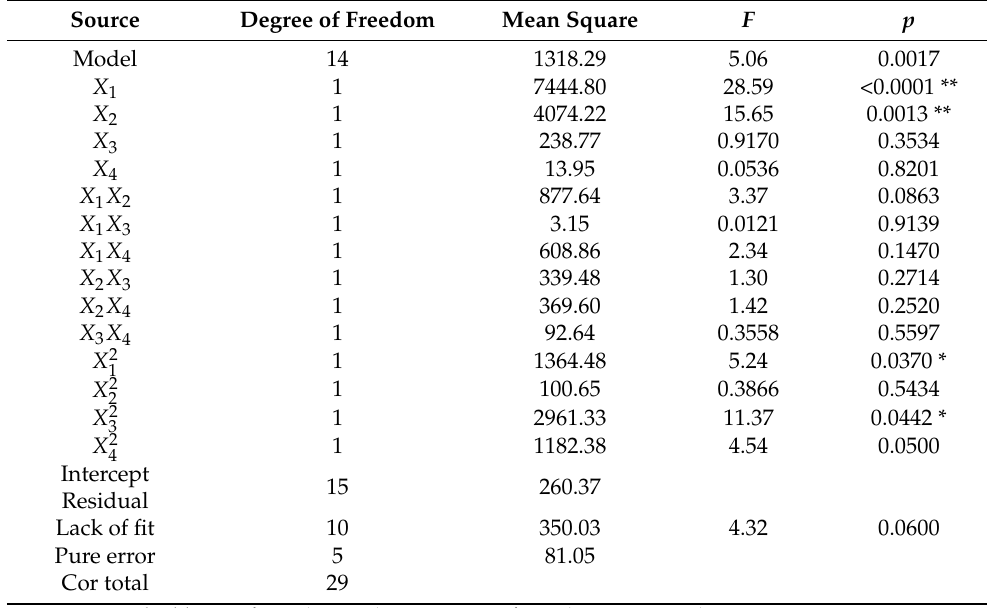
Table 5. Bending damage force response surface quadratic regression model analysis of variance.